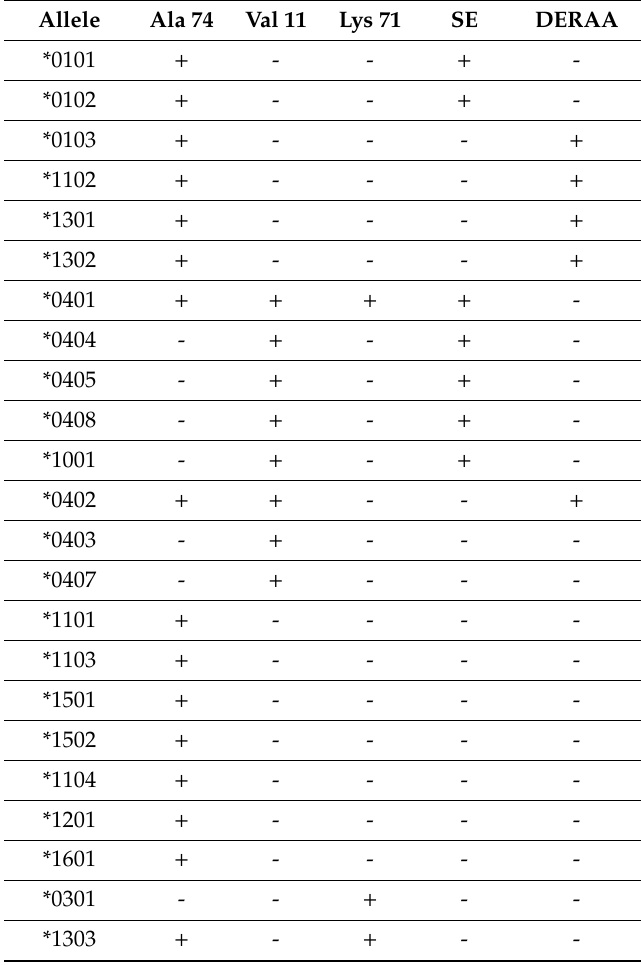
Table 1. HLA-DRB1 alleles encoding amino acids at Positions 11, 71, 74 the “shared epitope” (SE) motif (associated with increased risk of RA) and the DERAA motif (associated with a reduced risk of RA). Several HLA alleles share overlapping amino acid sequences. The coexistence of the “shared epitope” motif and Val 11, Lys 71, Ala 74, is the most strongly associated with RA in Caucasians and it corresponds to the DRB1*0401 allele. Source: Data from Cruz GI, et al. Ann Rheum Dis 2017; 0: